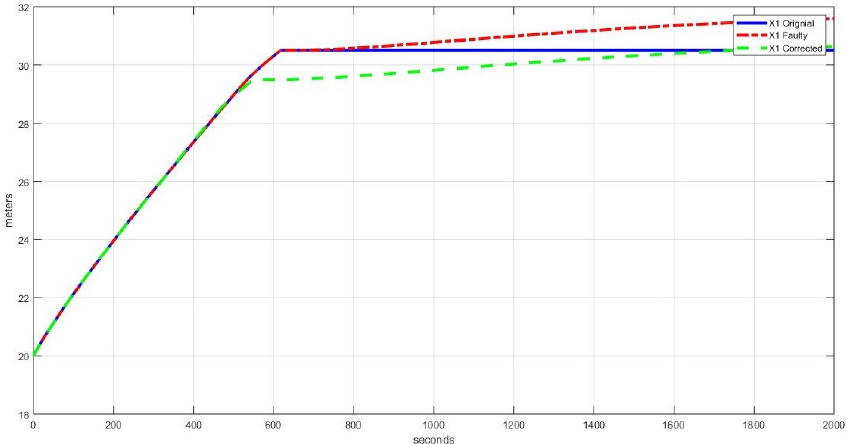
Figure 19. Pond 0 with normal, faulty, and fault-corrected operation given a sluice gate 𝑤 (cid:2869) leakage fault.